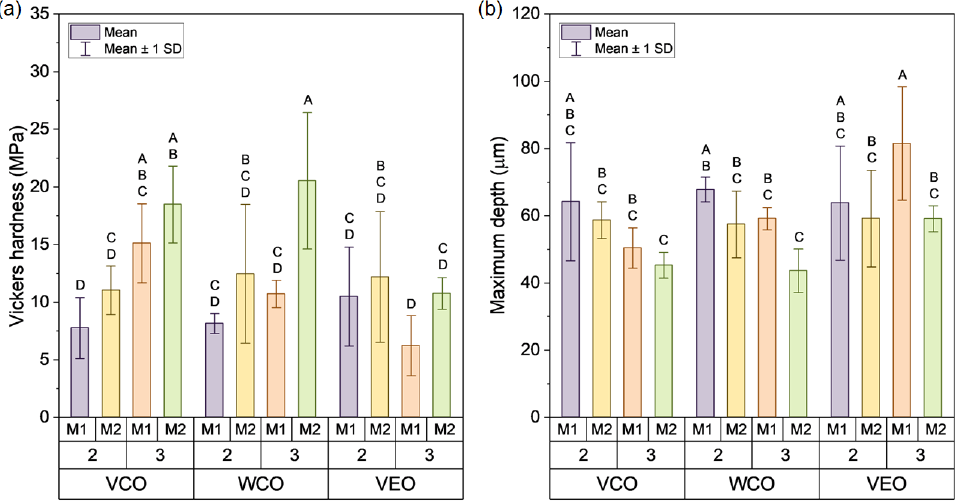
Figure 9. Average results of ( a ) Vickers hardness and ( b ) associated maximum indentation depth.